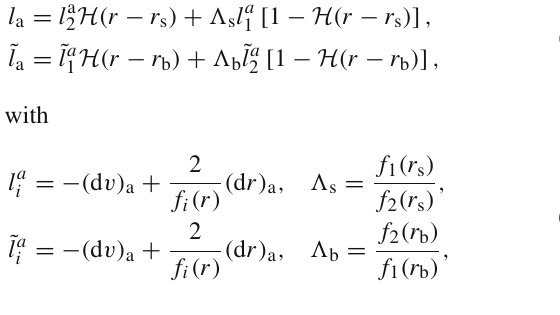
see that the dynamical point r s approaches the horizon H 2 , +